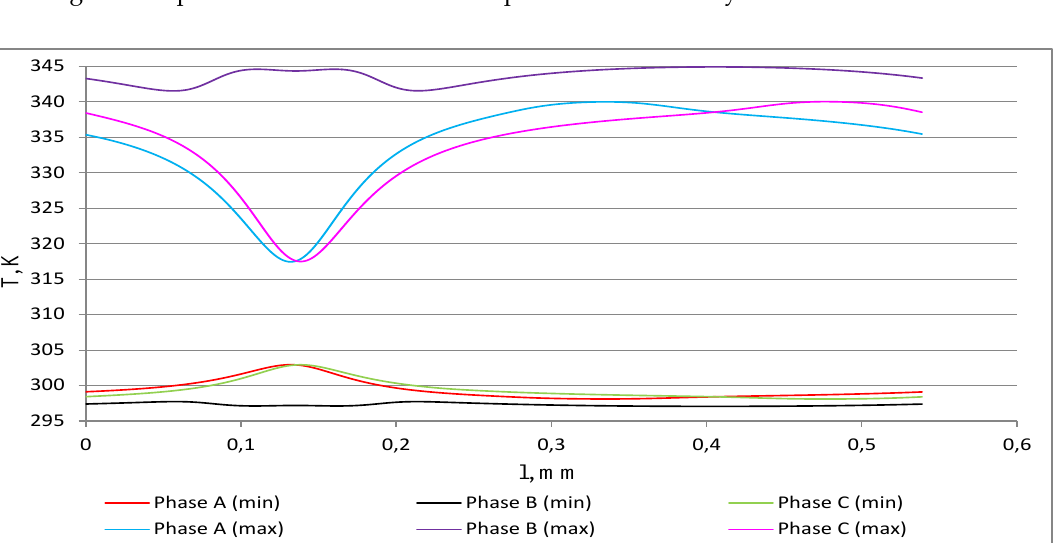
Figure 10. Temperature distribution on the surface of the cable placed in the pipes for the minimum (min) and maximum (max) temperature difference in a triangular